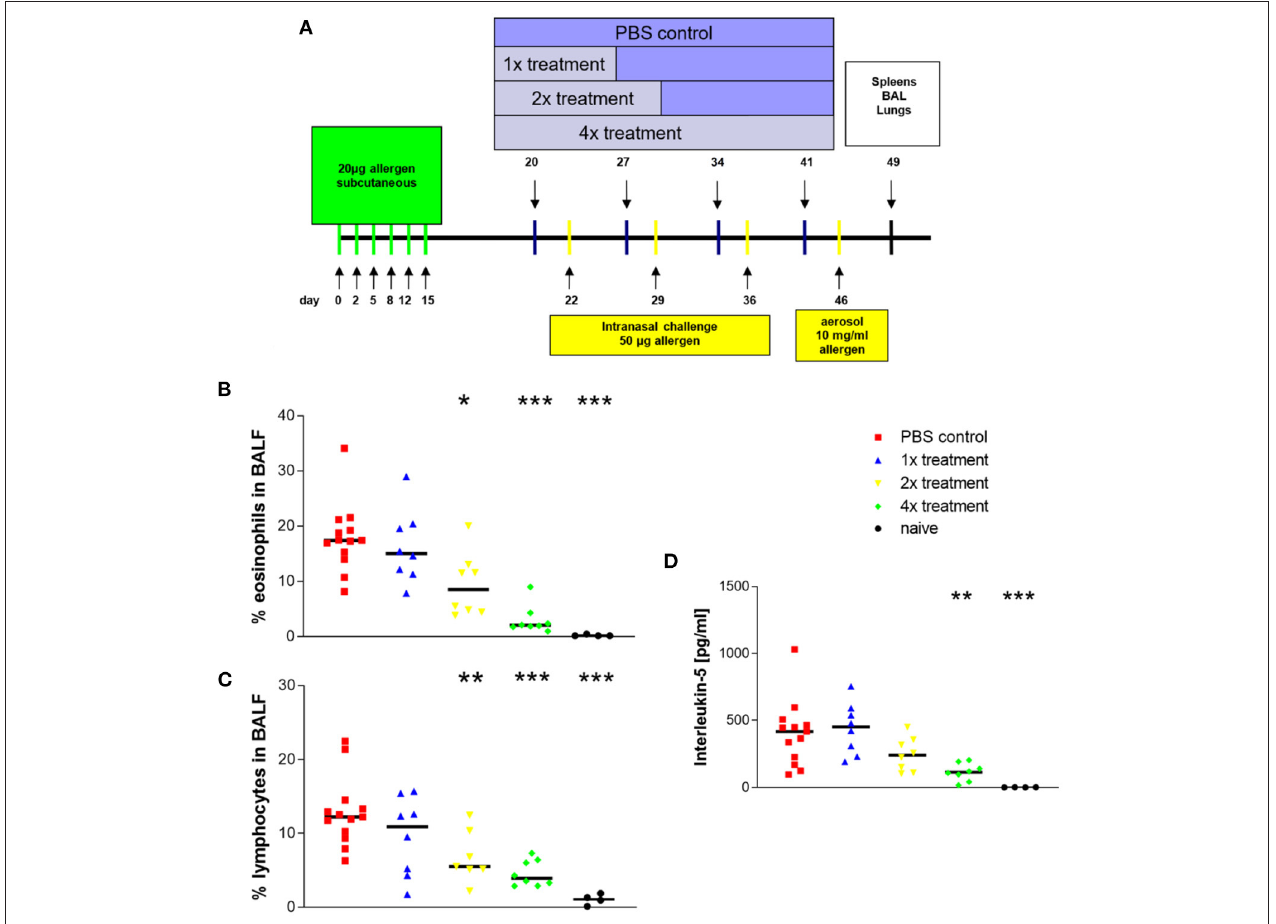
FIGURE 1 | Eosinophilic airway inflammation that is induced with Phl p5b is reduced by allergen-specific immunotherapy. Design of in vivo experiments (A) Systemic sensitization was done by six s.c. injections of 20 µ g allergen. A maximum of four s.c. injections of 1mg allergen were given in an interval of 1 week. Challenges were done by three i.n. applications of 50 µ g allergen dissolved in 50 µ l phosphate buffered saline (PBS) each 1 week apart. The last challenge was performed by the aerosol challenge (10 mg/ml) via the airways. For analysis of the allergic immune response, splenocytes and bronchoalveolar lavage fluids and lungs were harvested on day 49. (B) Effect of treatment on the ratio of eosinophils in bronchoalveolar lavage fluids. (C) Effect of treatment on the ratio of lymphocytes in bronchoalveolar lavage fluids. (D) Effect of treatment on cytokine production of in vitro restimulated splenocytes (10 7 cells). Phl p5b was used in a final concentration of 100 µ g/ml. The increasing number of treatment of mice by immunotherapy results in decreasing IL-5 production by restimulated splenocytes. Naïve mice were untreated. n = 4–13 per group, * p < 0.05, ** p < 0.01, *** p < 0.001 compared to PBS-treated control group, determined by unpaired Mann-Whitney test. s.c., subcutaneous; i.n., intranasal.